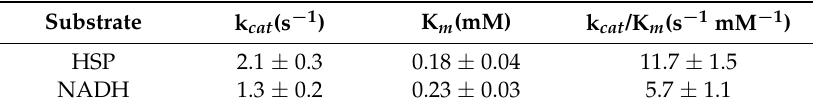
Table 2. Kinetic parameters of HSPH ZZ for the substrate of HSP or NADH a .